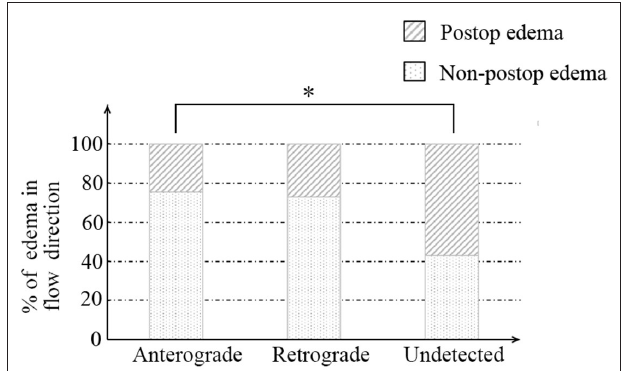
FIGURE 3 | The relationship between recipient flow direction and postoperative cerebral edema. * indicates p < 0.05.